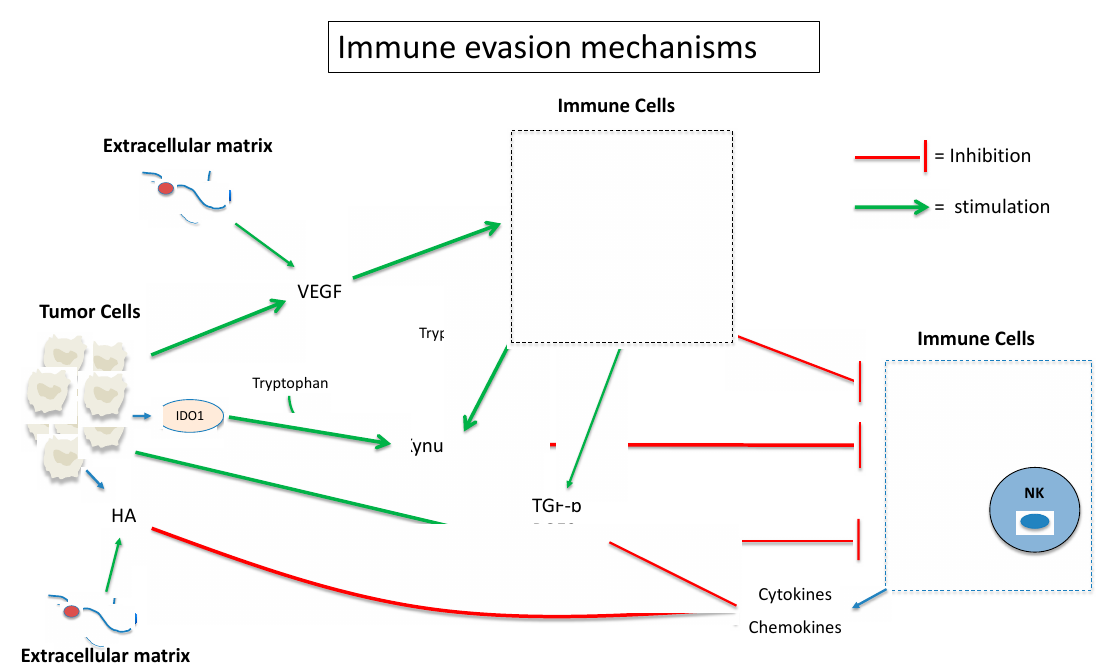
Figure 4. Bladder cancer was characterized by a highly immunosuppressive environment. Tumor cells secrete various immunosuppressive and anti ‐ apoptotic factors (vascular endothelial growth factor (VEGF), TGF ‐β , IL ‐ 10 and IL ‐ 6, prostaglandine E2 (PGE2)) that create a tolerogenic microenvironment with accumulation of ICs harboring immunosuppressive phenotypes. Table 2. Overview of important trials evaluating potential combinations with immune checkpoint inhibitors in metastatic urothelial carcinoma.